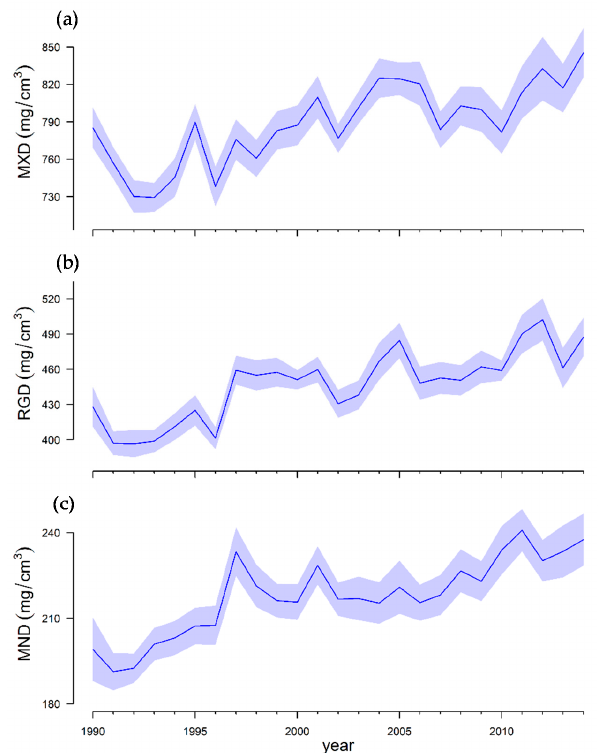
Figure 5. Maximum (( a ), MXD), mean (( b ), RDG) and minimum (( c ), MND) wood density of Douglas fir in the Beamaburu site (1990–2014). The figure shows the mean and the 95% confidence intervals across individuals.